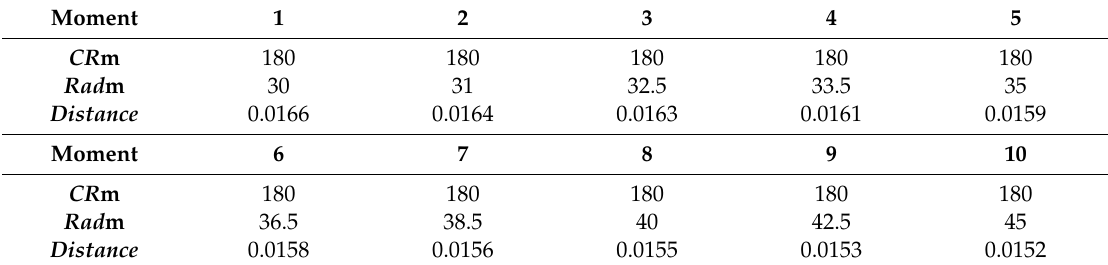
Figure 9. The trajectories of the two encountering ships in an overtaking scenario. Table 7. The results in an overtaking encountering scenario.